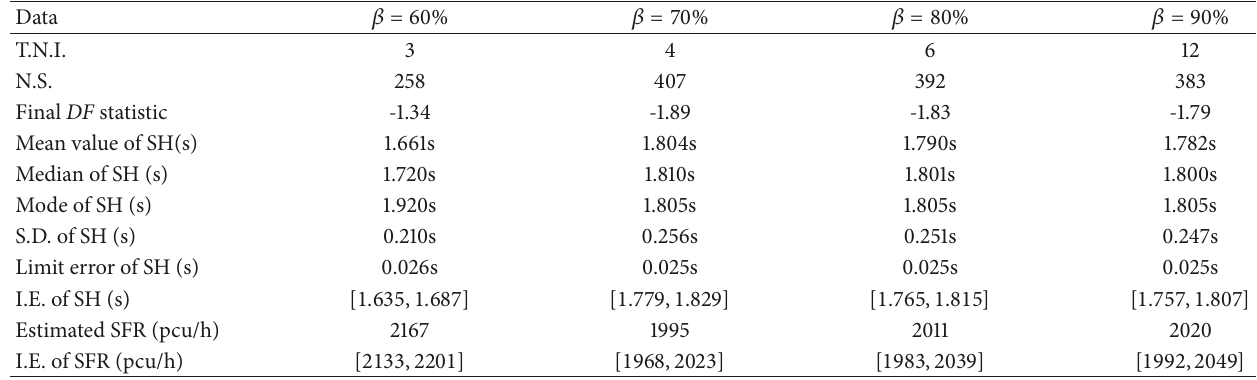
Table 6: SFR estimations based on the 60%, 70%, 80%, and 90% quantiles for lane 2.